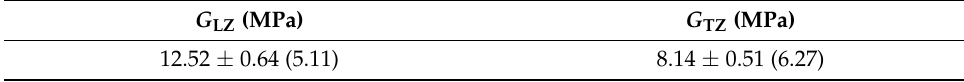
Table 5. G LZ and G TZ values calculated by using Equation (11).